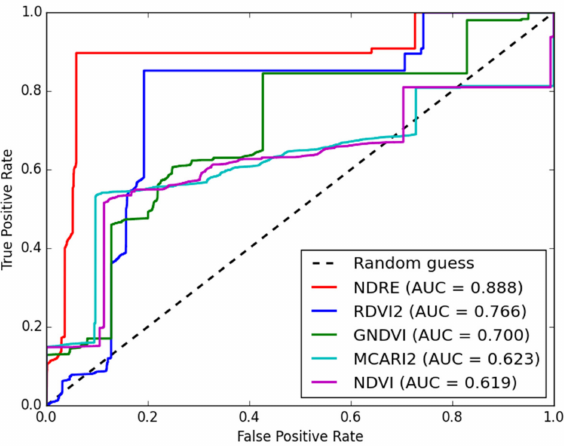
Figure 14. ROC curves and AUC values for VIs